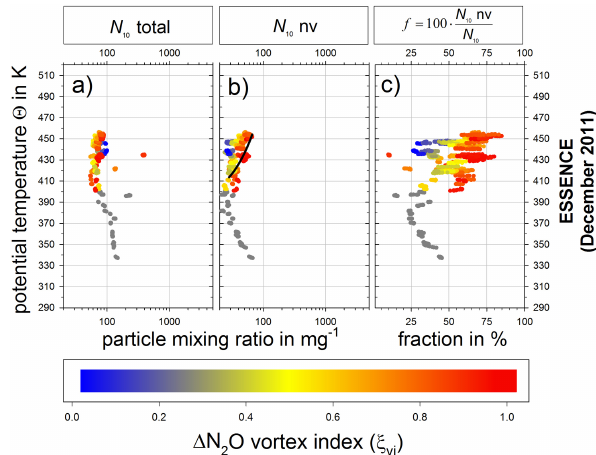
Figure 4. Structured as Figs. 2 and 3 for the ESSenCe campaign in 2011 with the color-coding of data according to the (cid:49) N 2 O vortex index ξ vi . For (cid:50) below 400K, data points are left in gray as in- side or outside vortex air cannot be apportioned unambiguously (cf. Sect. 2). Black lines indicate a regression of data points that fulfill the inside-vortex criterion (Sect.